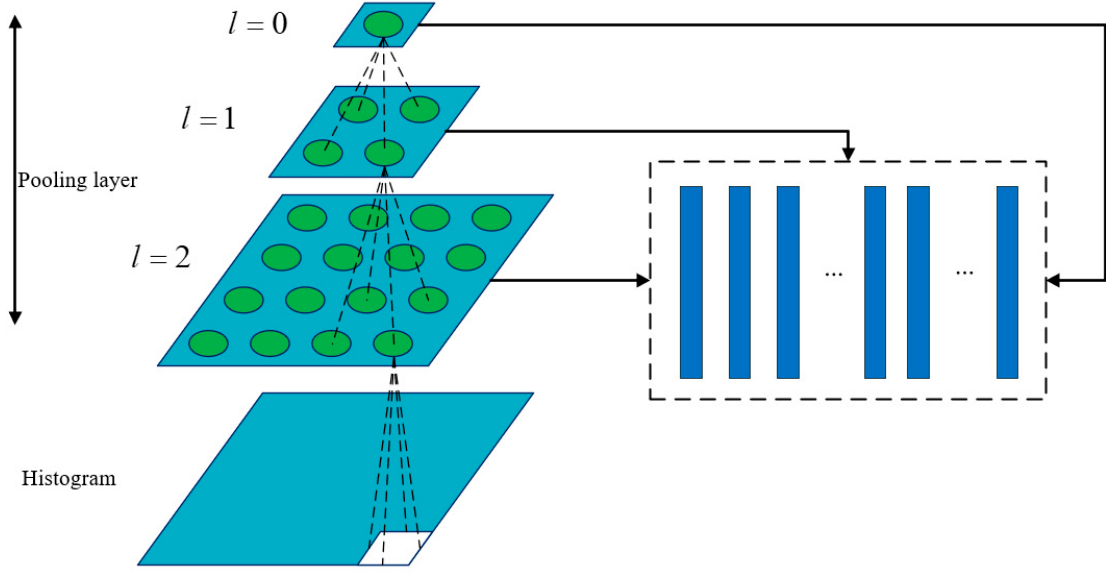
Figure 3. Feature pyramid pooling